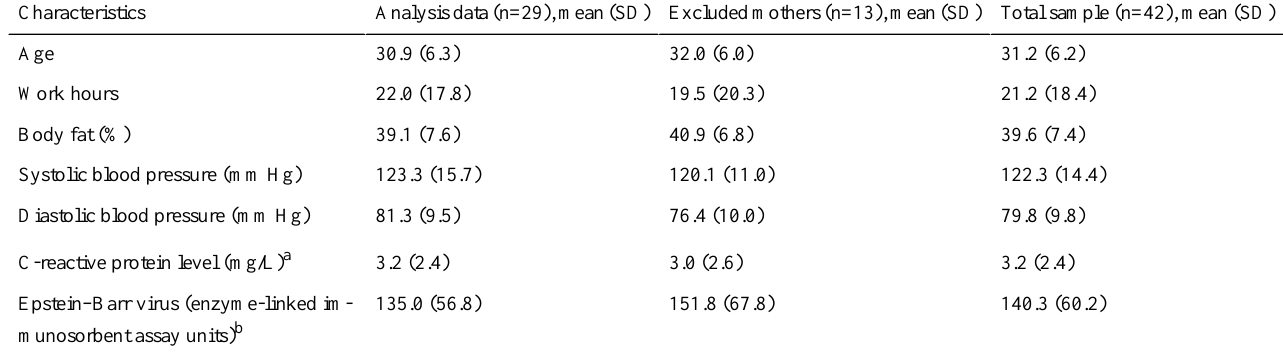
Table 3. Demographic and baseline biomarker characteristics of mothers who were included and those excluded from the analyses due to low ecological momentary assessments completion